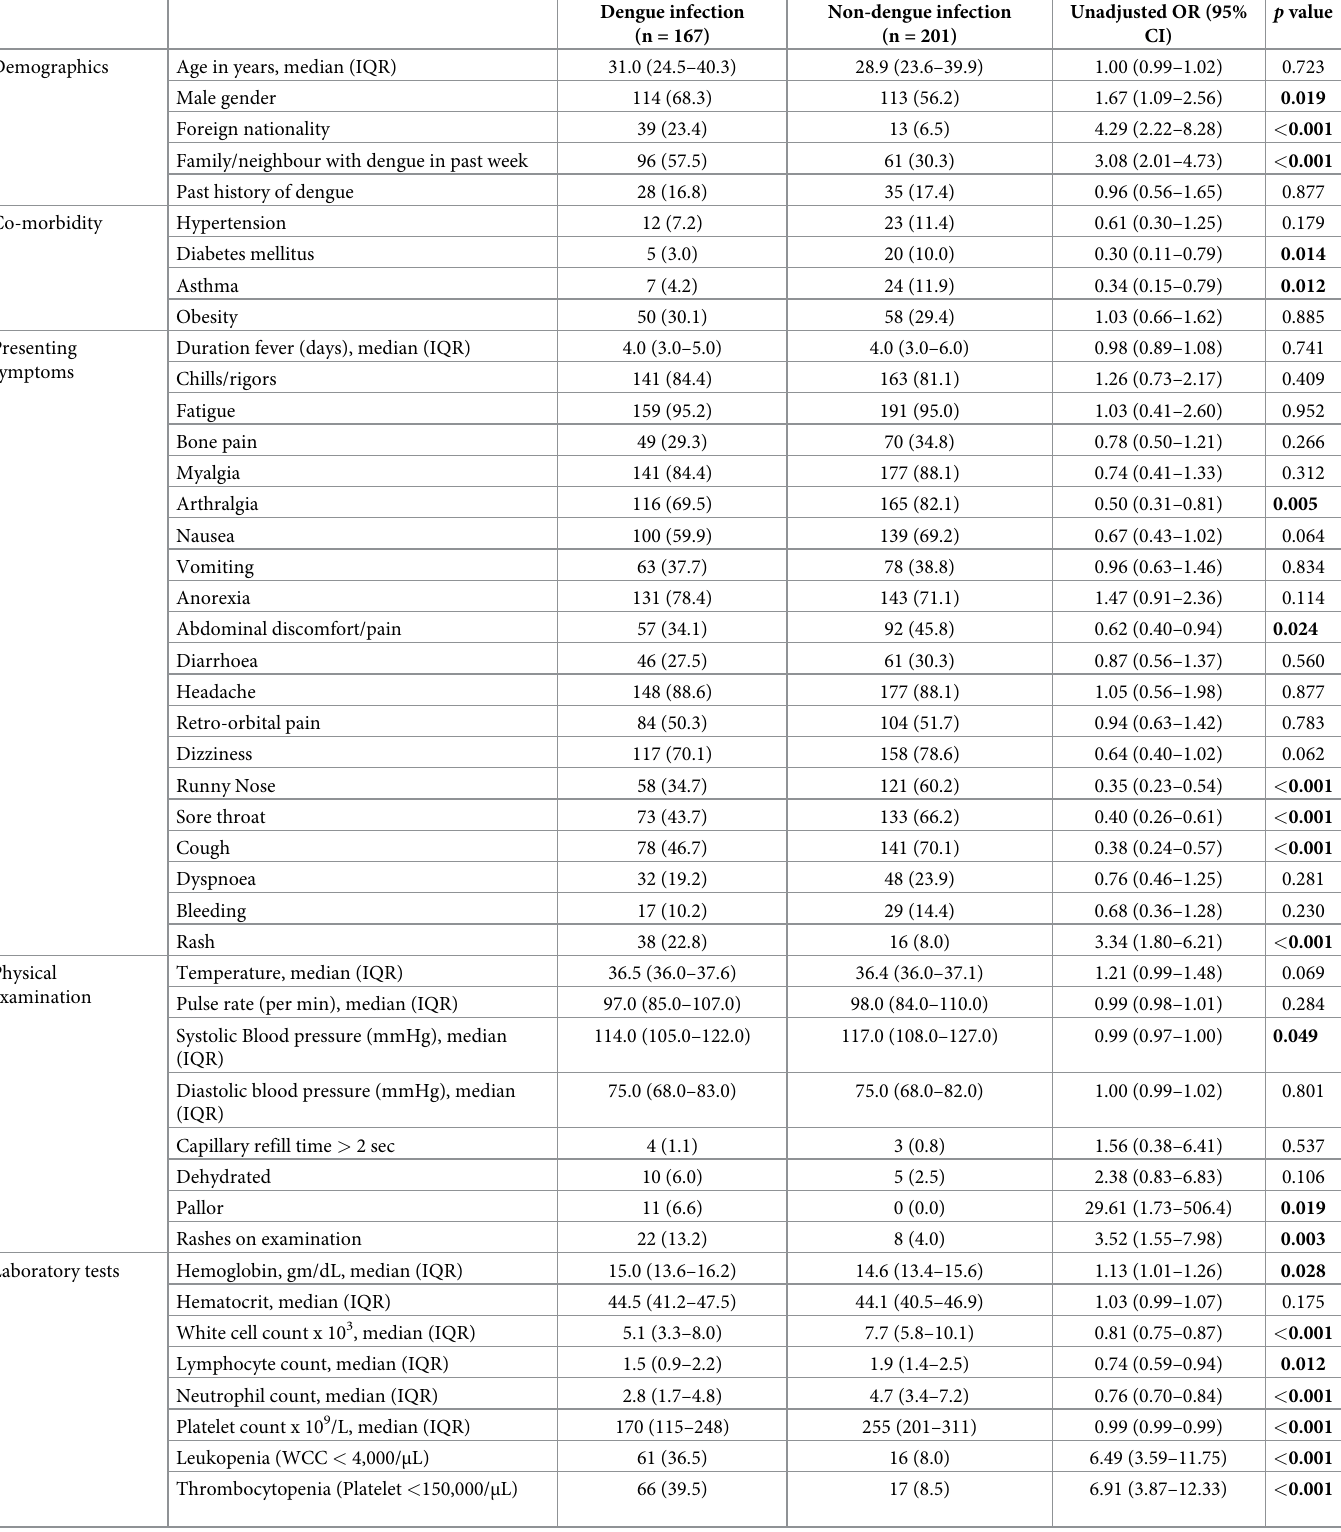
Table 3. Clinical demographics and laboratory parameters comparing participants with dengue infection and participants without dengue